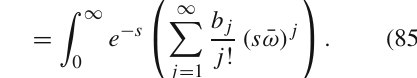
in powers of ω is an asymptotic. For a given value of ¯ ω